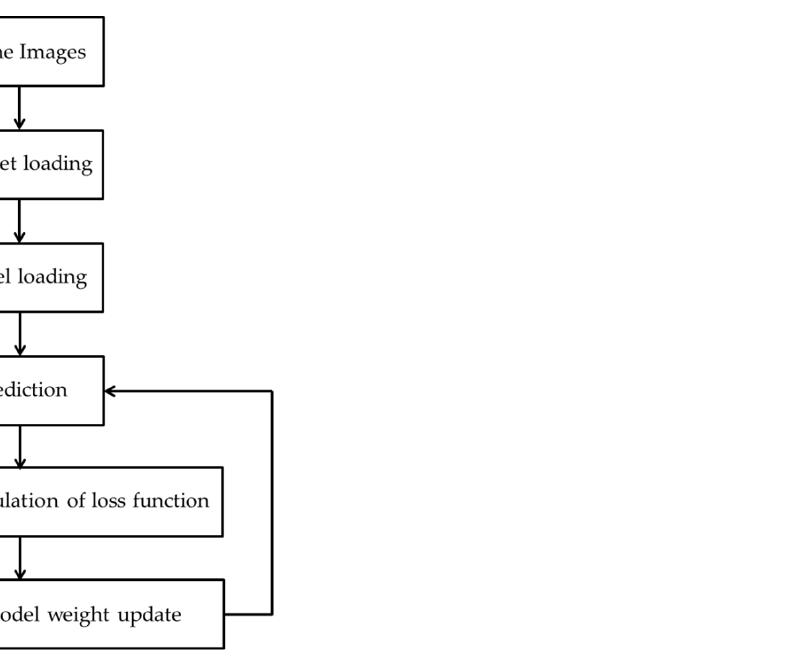
Figure 10. The structure of experimental method.